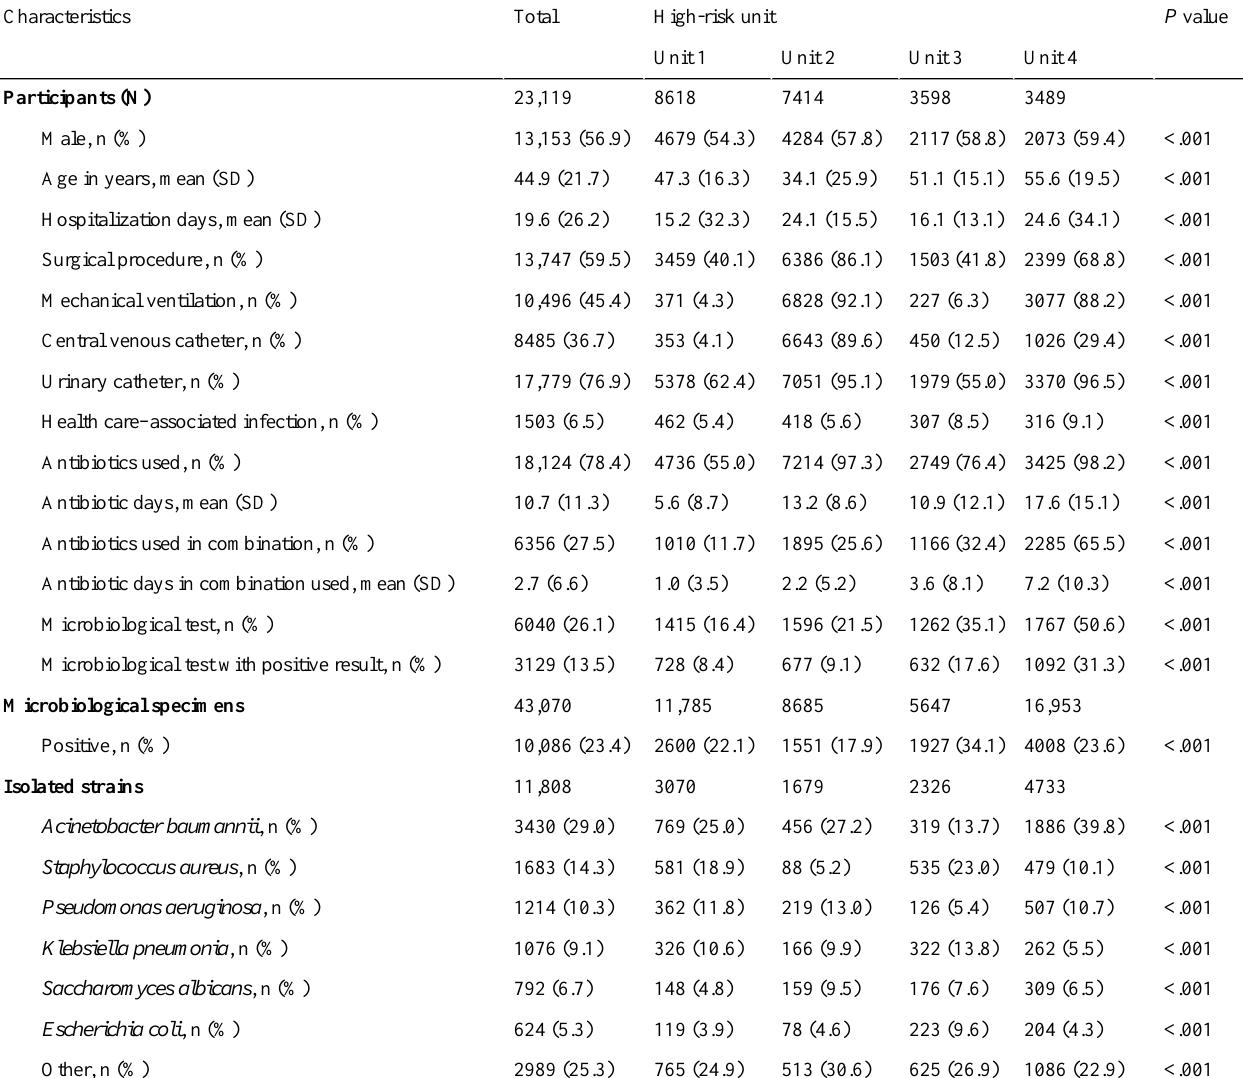
Table 1. Demographic characteristics of inpatients in the 4 high-risk units in Wuhan Union Hospital during the surveillance period.